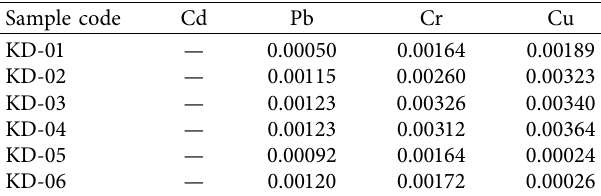
Table 4: Estimated daily intake (EDI) of heavy metals in adults through the consumption of traditional herbal preparations.